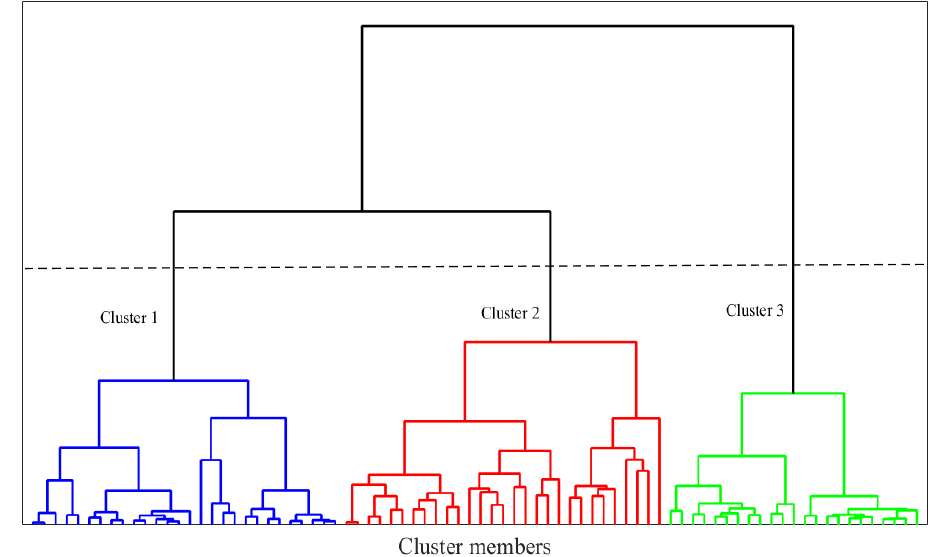
Figure 2. Example of Raman cluster